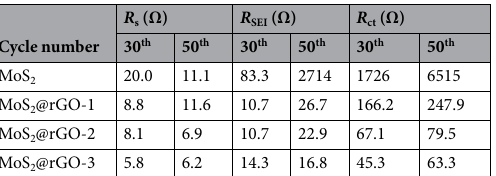
R s (Ω) R SEI (Ω) Cycle number